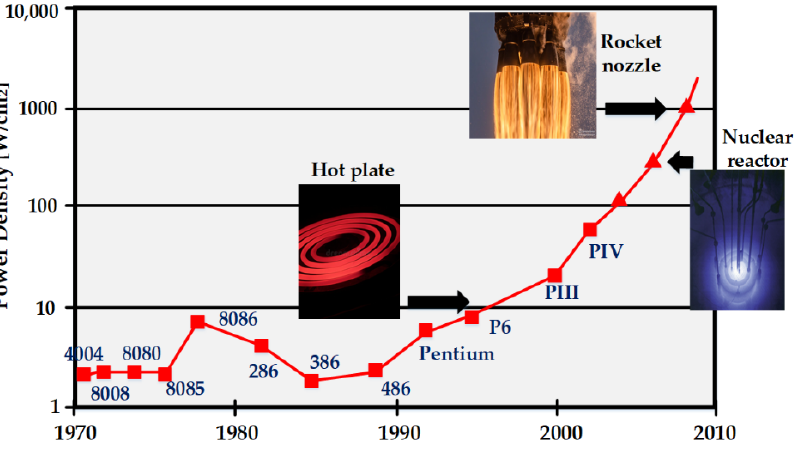
Figure 5. Trend of heat dissipation with the increase in power density of Intel chips. Later, the performance bottleneck in microprocessors was overcome by adopting parallel computing techniques using closely coupled multiple processor cores on a single chip [90]. In 2005, AMD released its first dual core processor, Athlon 64 X2 [86]. Intel also rushed into multi-core design and came up with the Core-2 Duo processor for desktop and laptop computers. Some processors, like the Intel Core-2 Duo, were designed with a shared level-2 (L2) cache, whereas Intel Pentium-D and AMD Opteron came with a private L2 cache for each core or processor [91]. Multi-processor chip (MPC) architecture further improved to quad and more cores and initiated a new era of performance gains